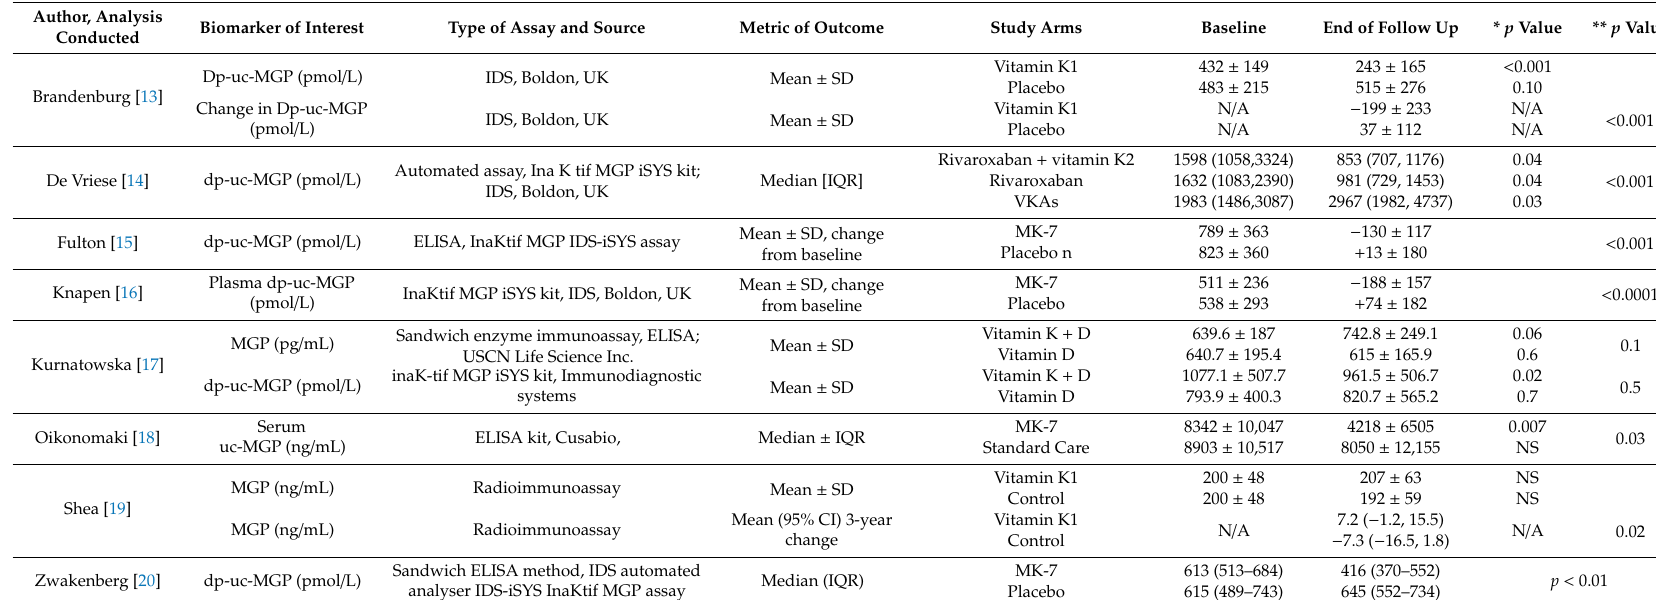
Table 7. E ff ect of vitamin K supplementation on the change in